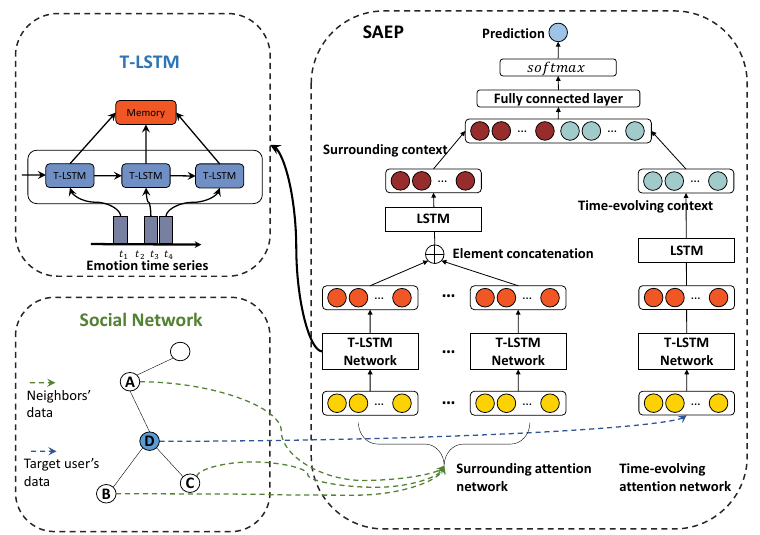
Figure 5. Basic process of SAEP